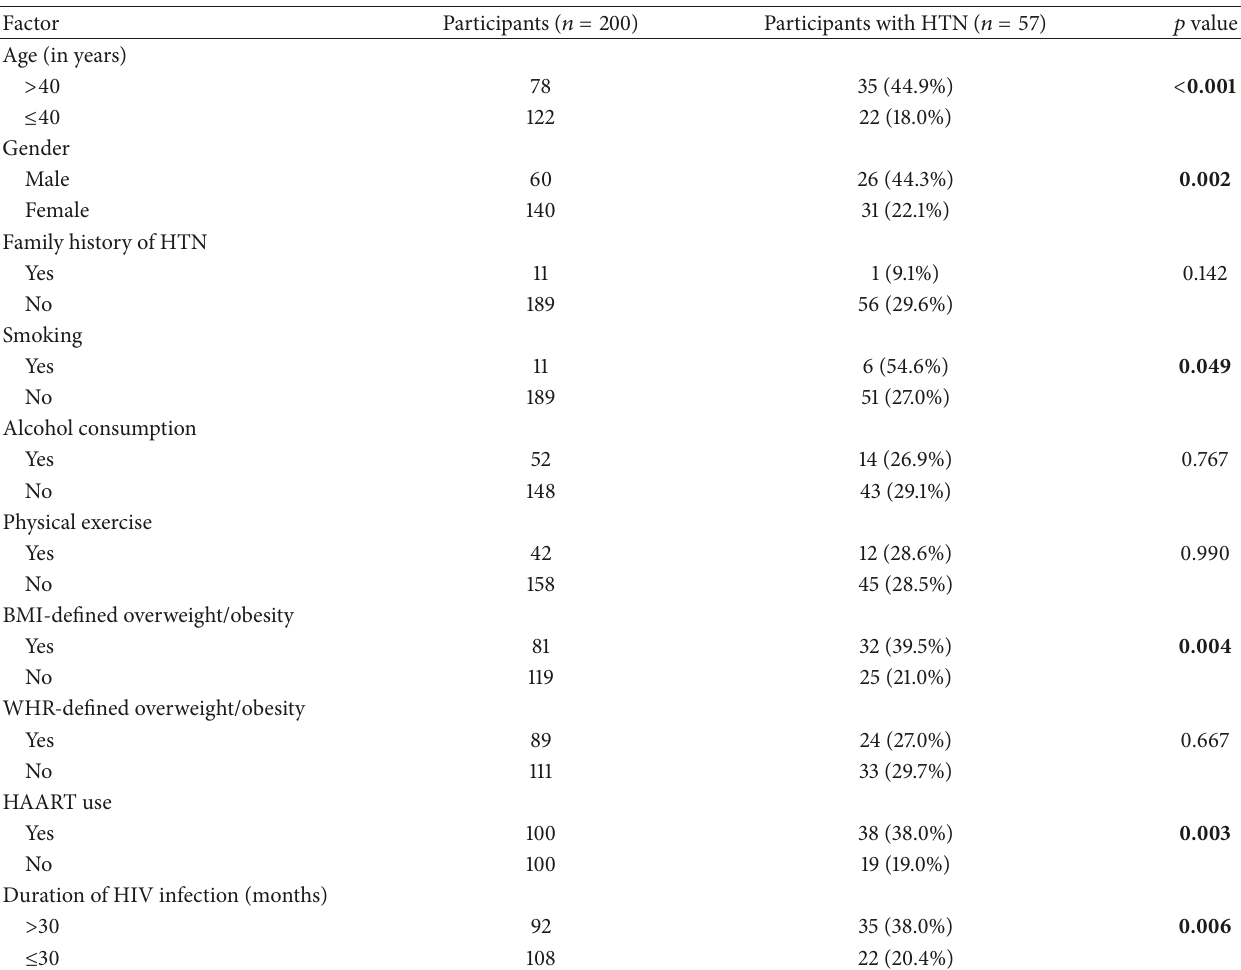
Table 2: Factors associated with hypertension in the study population.